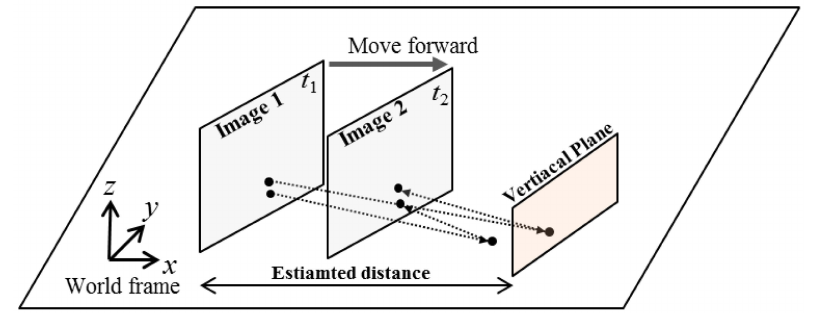
Figure 9. Illustration of virtual vertical-plane set up for IPM-based detection.